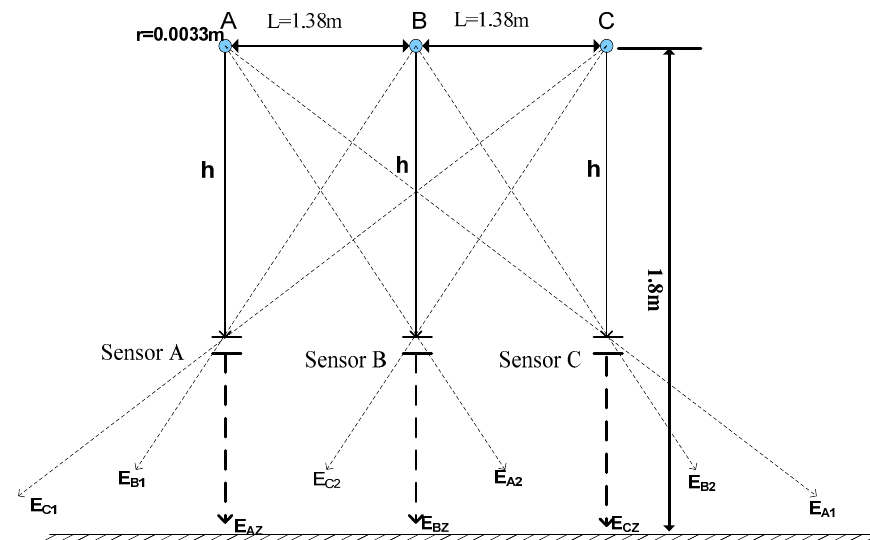
Figure 2. Decomposition of the electric field for the horizontally arranged line.